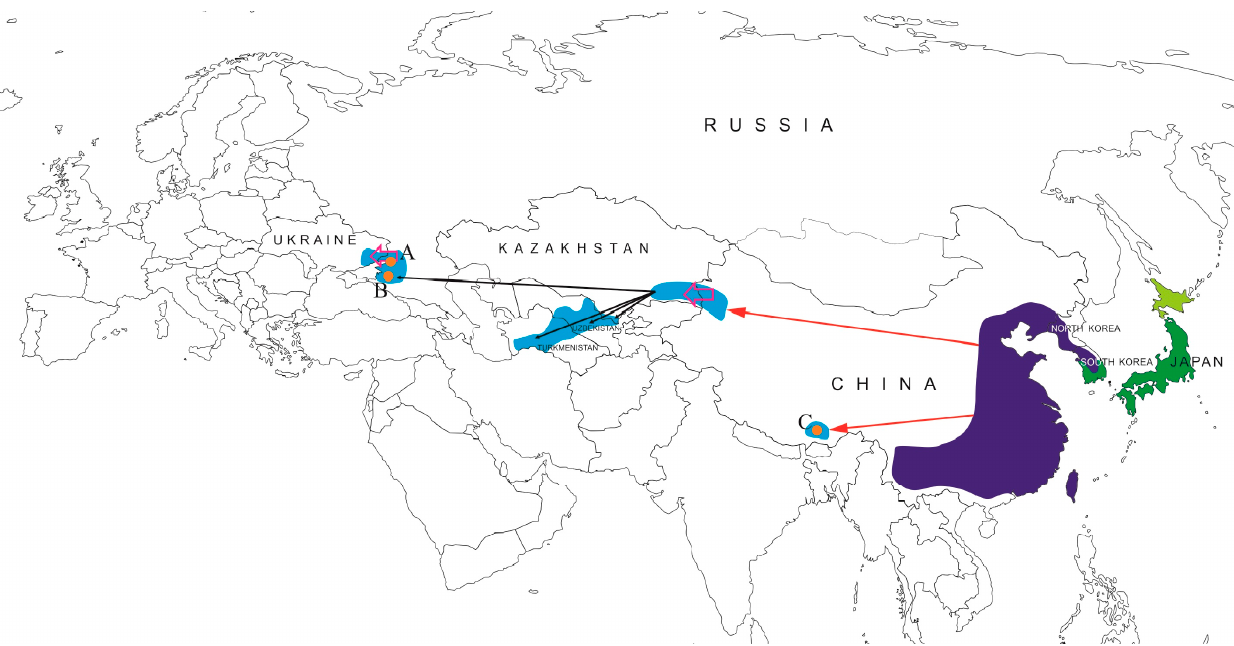
Figure 1. Map of Eurasia indicating the localities of ricefish ( Oryzias ) samples in the Rostov Region (A) and the Krasnodar Territory of the Russian Federation (B), as well as the Tibet Autonomous Region of China (C). Dark blue and light blue colors show the native and invaded ranges of the Chinese ricefish, Oryzias sinensis , respectively. Dark green and light green colors show the native and invaded ranges of the Japanese ricefish, O. latipes , respectively. Red arrows show probable translocations outside of the native range; black arrows show documented intentional secondary transportations. Wide open pink arrows show local short-distance translocations and self-distribution within river basins.